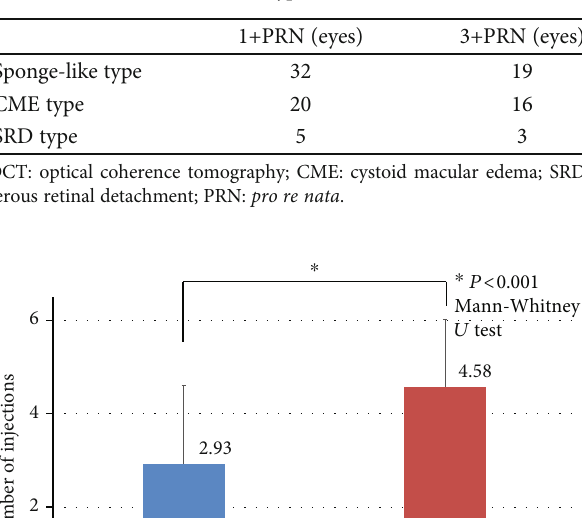
Table 1: Baseline characteristics of the patients. Table 2: Di ff erent types of DME on OCT.